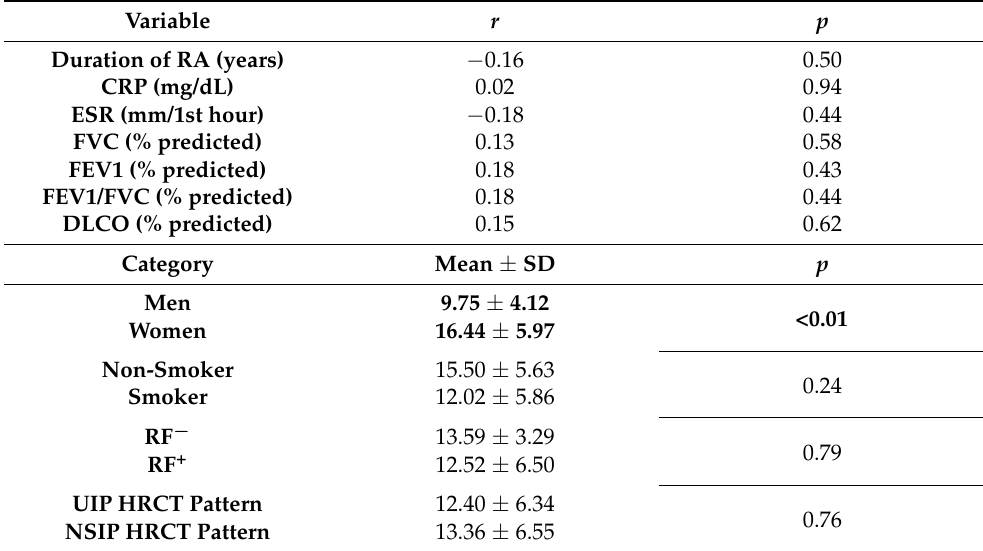
Table 2. Relationship of TAng frequency with characteristics of RA-ILD +